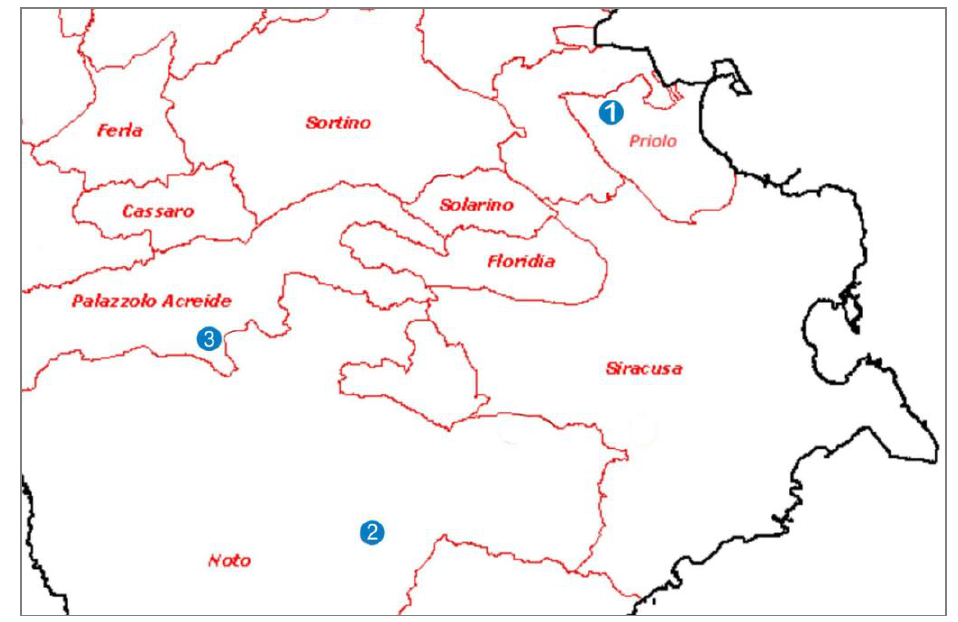
Figure 2. Individuation of new quarry of Priolo ( 1 ); Noto ( 2 ); and Palazzolo ( 3